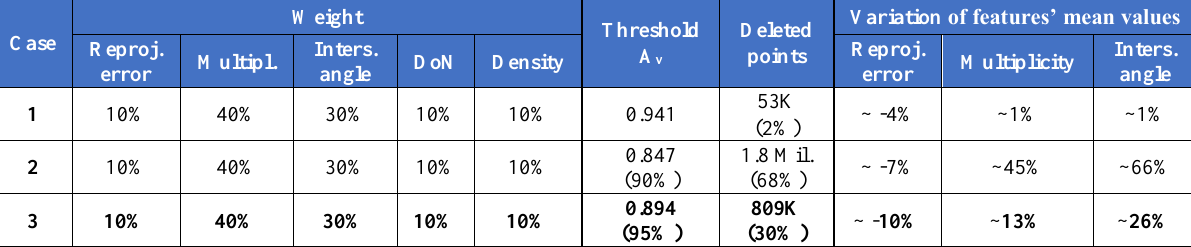
Table 3: Weights, aggregated filtering thresholds, deleted 3D tie points and internal quality values improvements for the best weights’ combination (highlighted box in Figure 8) applied to filter the sparse point cloud. The first case considers the A v threshold derived by photogrammetric principles and empirical experiments (Section 4.4). Case 2 and 3 investigate a lower A v threshold (90% and 95%). Case 3 had the most balanced ratio between number of deleted points and improvements of the considered quality features (lower reprojection error and higher values of multiplicity and maximum angle).